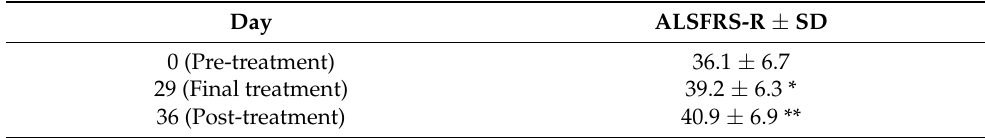
Table 2. Change in ALS patient functional rating over the ILB ® treatment period assessed by ALSFRS-R.